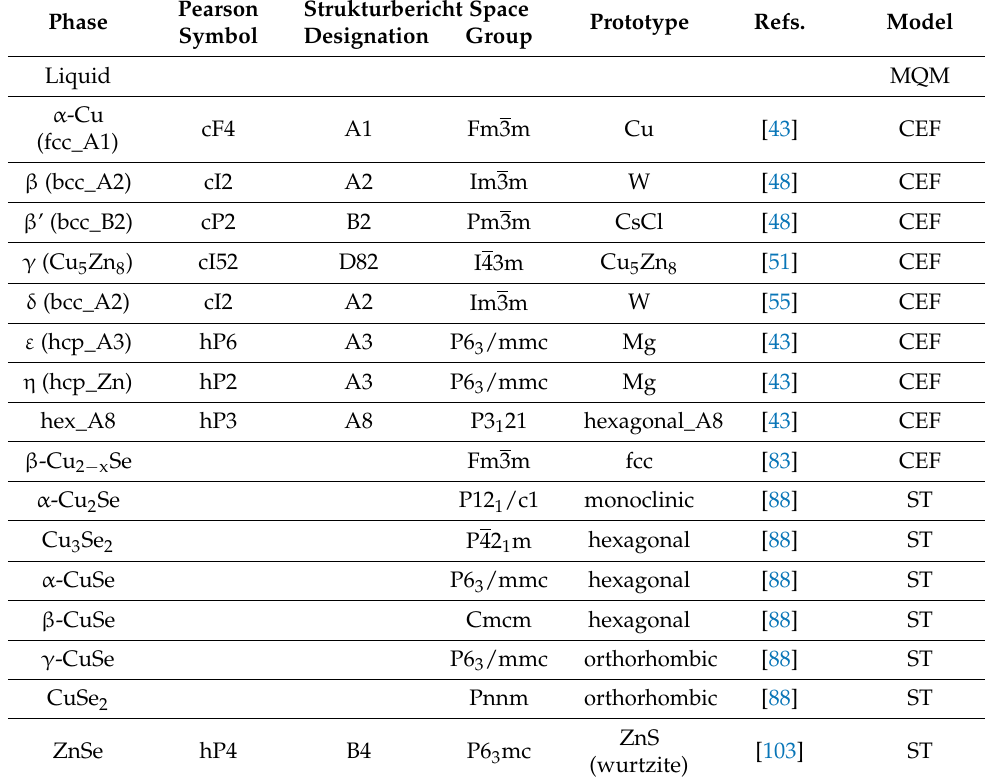
Table 4. Structural parameters of the phases and thermodynamic models used in the present work. Phase